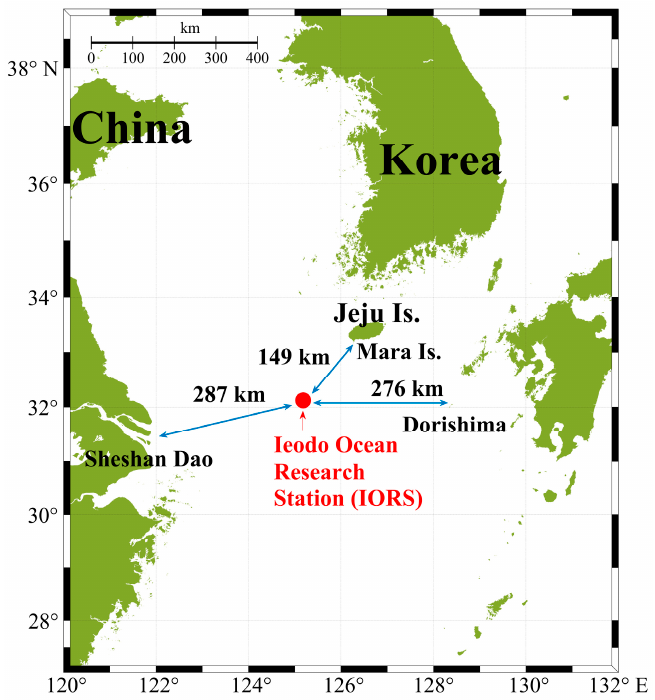
Figure 1. Location of the Ieodo Ocean Research Station (IORS). IORS is situated on Ieodo Rock, an underwater rock located approximately 149 km southwest of Mara Island.